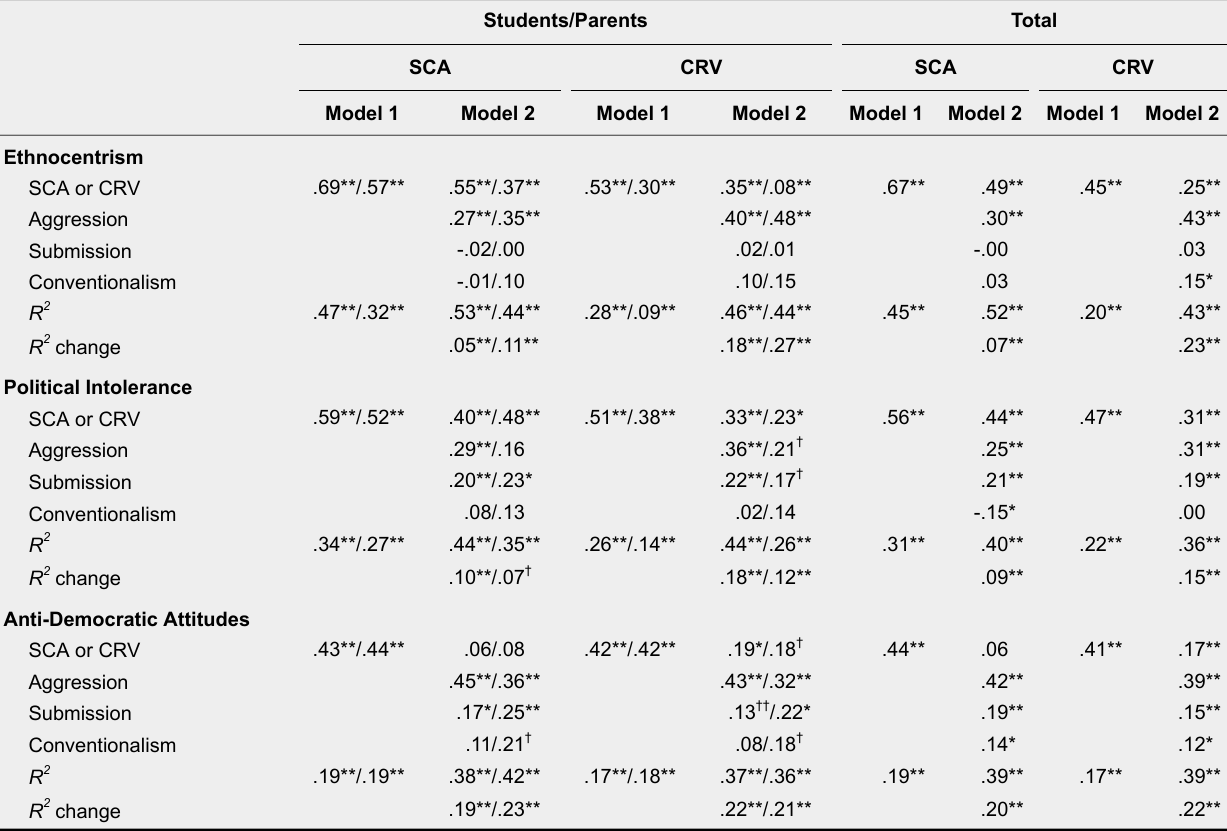
Beta Weights and R 2 Using Hierarchical Regression With Unidimensional Scales (SCA or CRV) Entered in Model 1 and ASC Subscales Entered in Model 2 for Predicting Ethnocentrism, Political Intolerance, and Anti-Democratic Attitudes in Sample